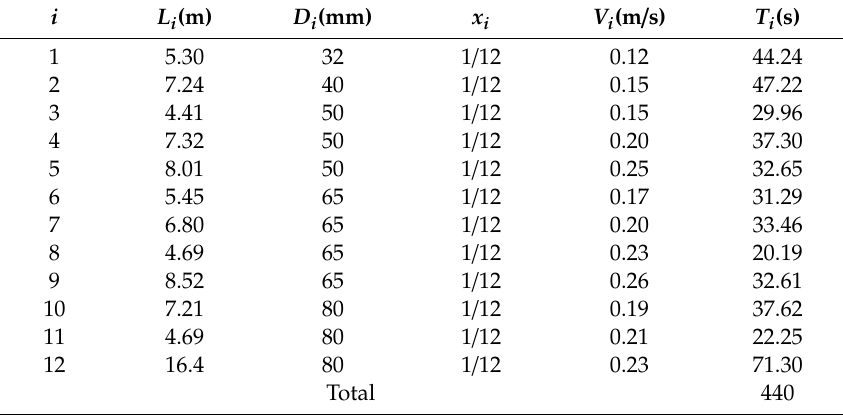
Table 1. The theoretical calculation of the time delay caused by the